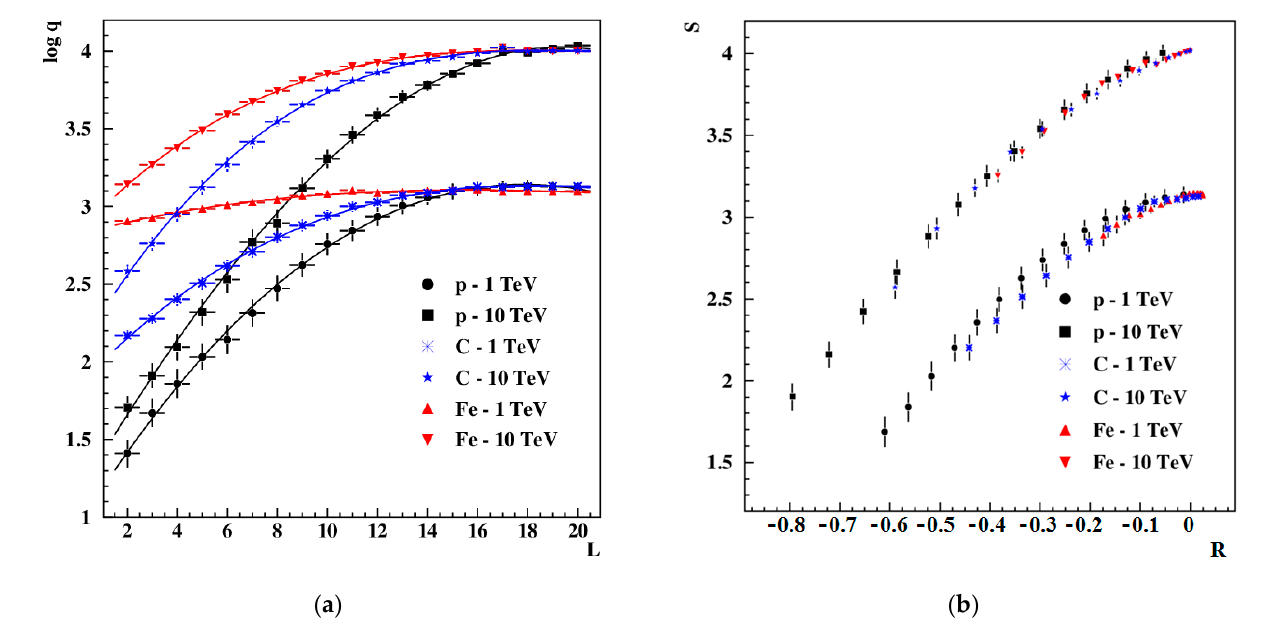
Figure 3. ( a ) Cascade curves for showers initiated by protons, C and Fe nuclei with energies of 1 TeV and 10 TeV in the PAMELA calorimeter; ( b ) The size–rate curves for the same showers.